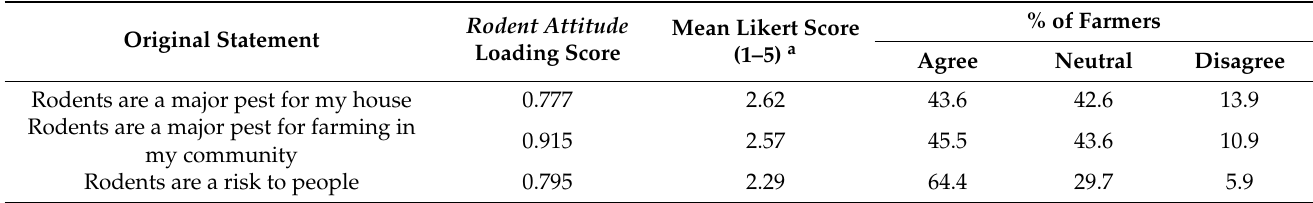
Table 2. Principal component analysis (PCA) loading rodent attitude (RA) score component, mean Likert score, and distribution (%) of agreement of farmers for statements related to attitudes to- ward